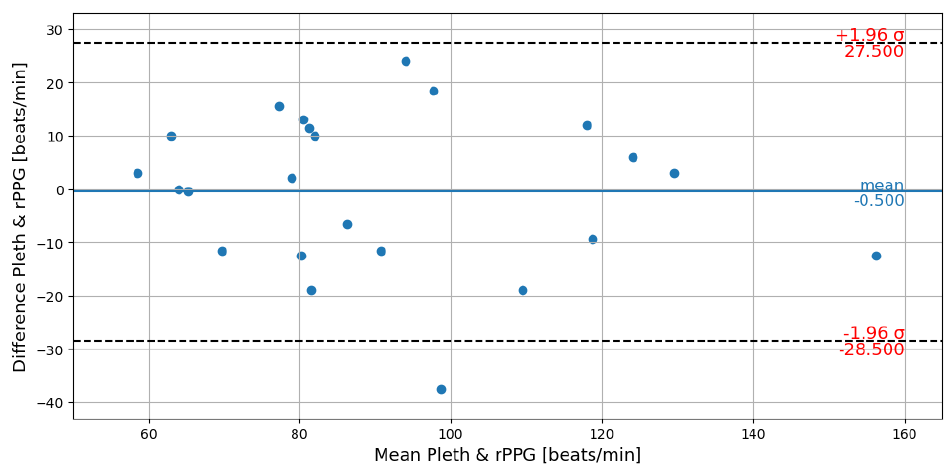
Figure 7. Bland–Altman plot of reference Pleth and rPPG.